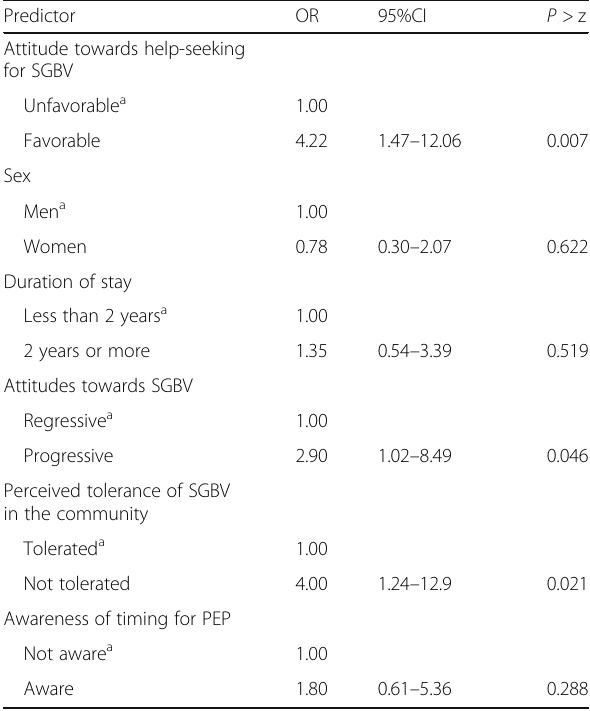
Table 5 Adjusted Odds ratios from a multivariate logistic regression model showing factors associated with help-seeking behavior for SGBV among men and women ( N =